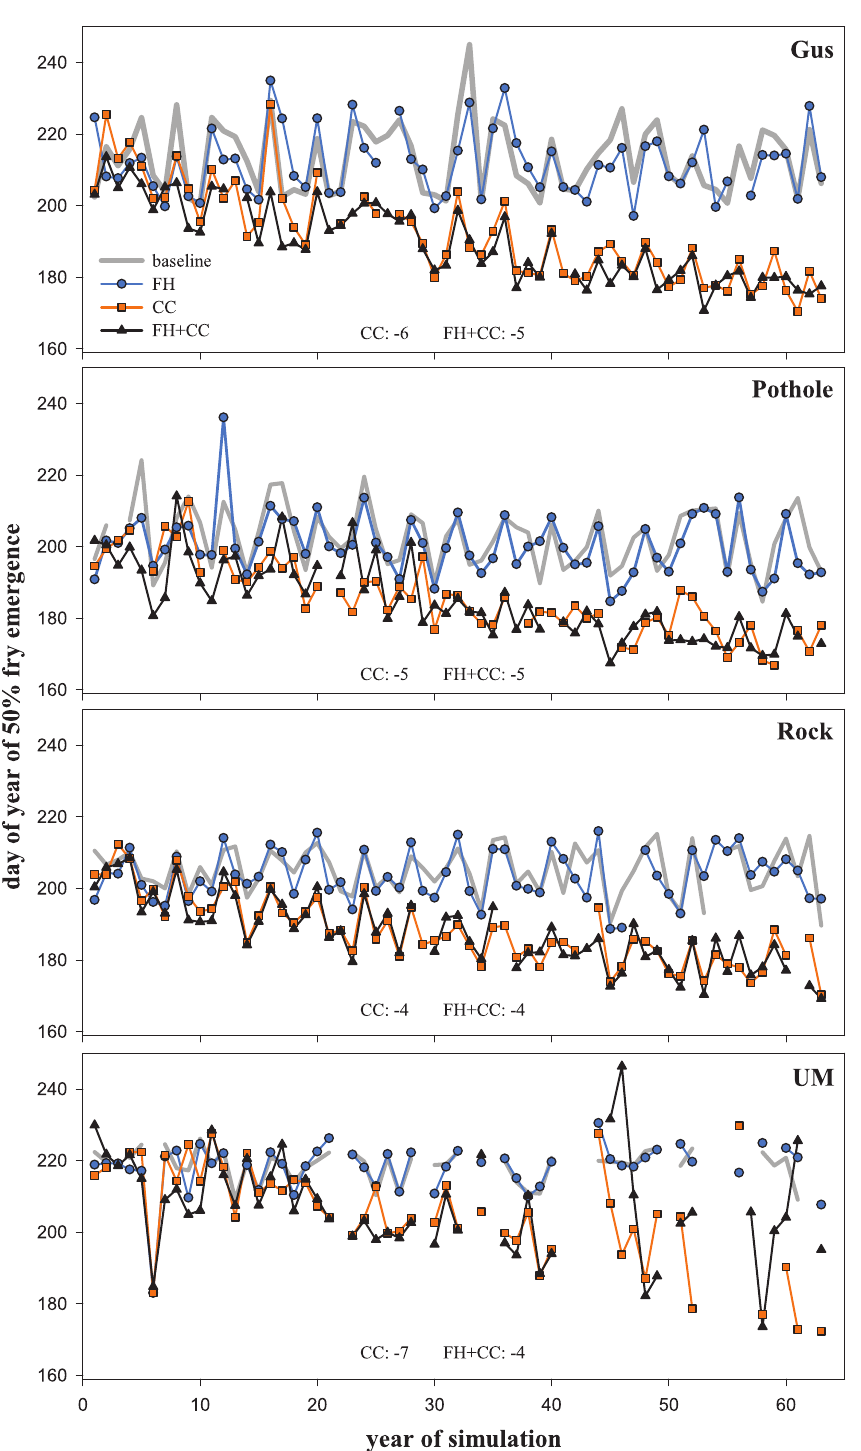
Fig 4. Trends in Fry Emergence of Trout across Scenarios. DOY from five replicate simulations when median number of modeled fry had emerged over time in Gus Creek, Pothole Creek, Rock Creek, and Upper Mainstem (UM). Scenarios include manipulations of stream temperature and flow regimes (see methods narrative for detail). Only significant trends (P < 0.05) over time are listed and include the slope of the trend (days per decade). Negative values represent early fry emergence. Gaps in data are due to years with no fry emergence because model thresholds for spawning, egg development, or emergence were not